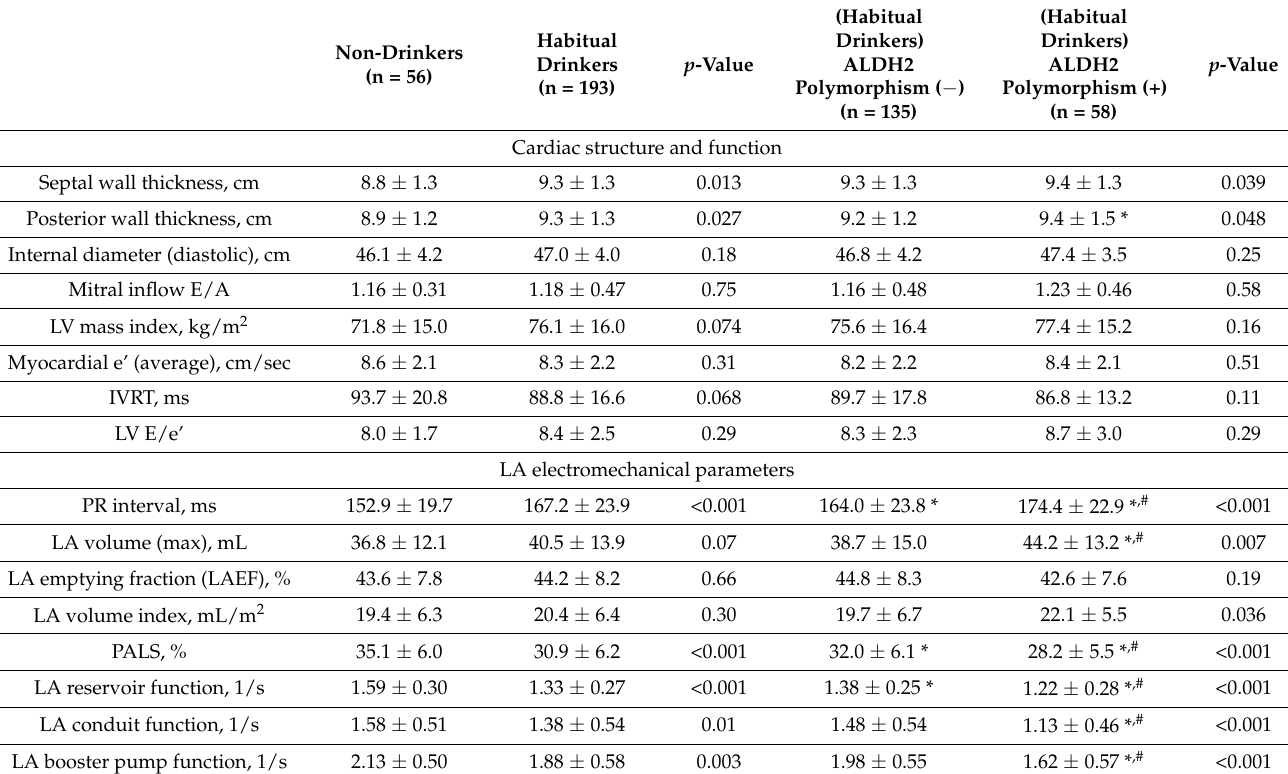
Table 2. Comparisons of cardiac structure and novel LA mechanical parameters across non-drinkers and habitual drinkers without and with the presence of ALDH2